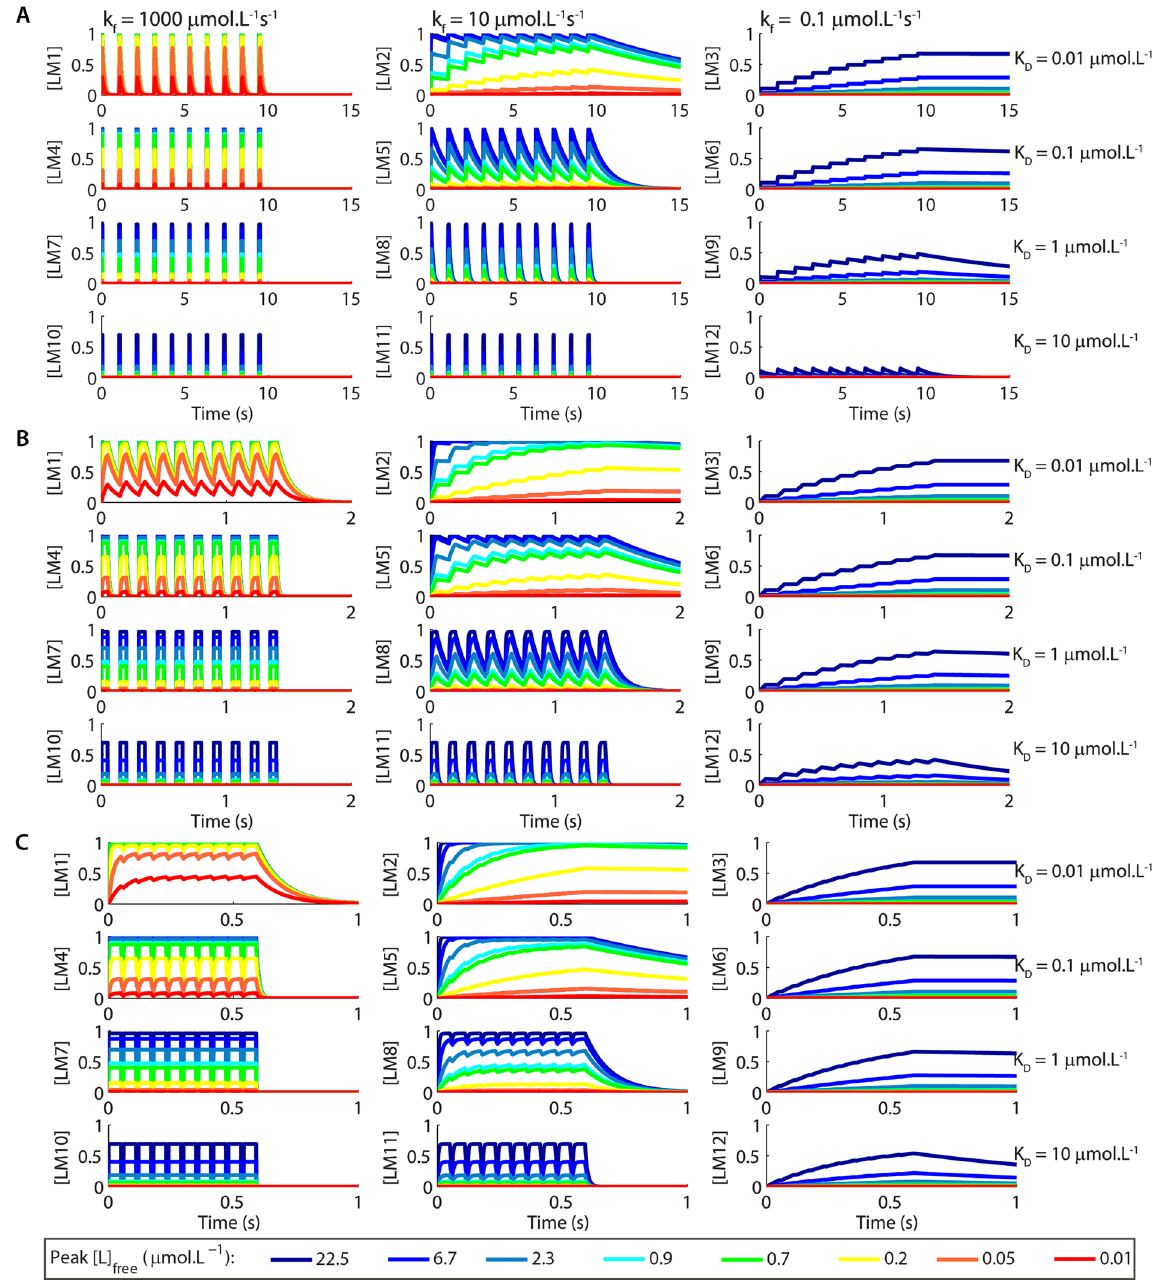
Figure 5. Examples of the time courses for the formation of LM1-LM12 obtained using trains of ten pulses of [L] free with different peak amplitudes released at 1 Hz ( A ), 10 Hz ( B ), or 100 Hz ( C ). Each pulse of [L] free had 50 ms of duration. The time courses of [L] free are showed in Suppl. Fig. S1A–C. The control K D s for the interactions of M1-M12 with L are showed on the right of the panels and the k f s for the association reactions are indicated in A . The legend indicates the colour code used to represent each concentration of [L] free